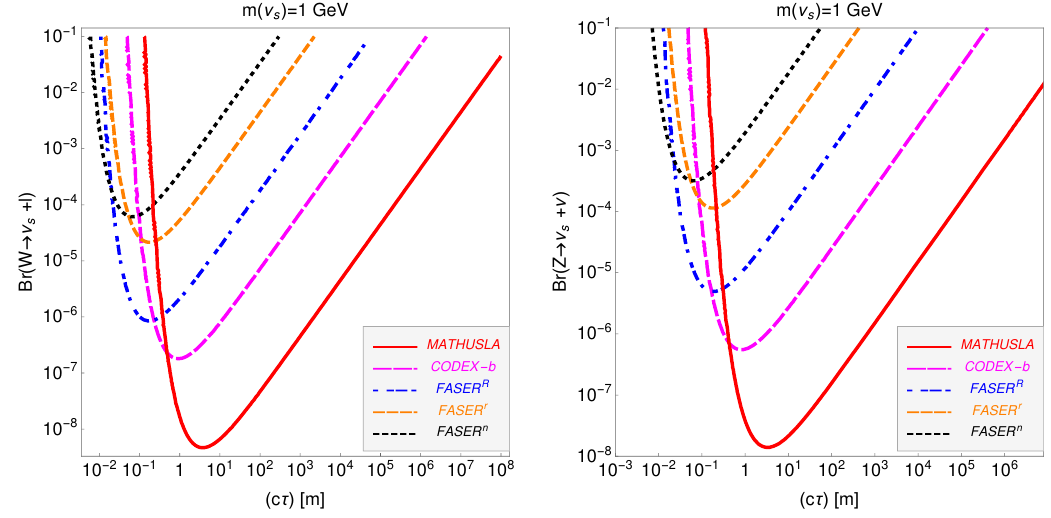
Figure 2 . Sensitivity estimates in the plane branching ratio versus decay length ( c(cid:28) ) for CODEX- b, FASER and MATHUSLA. The plot to the left is for neutral fermions from W decays, to the right for Z-boson production.